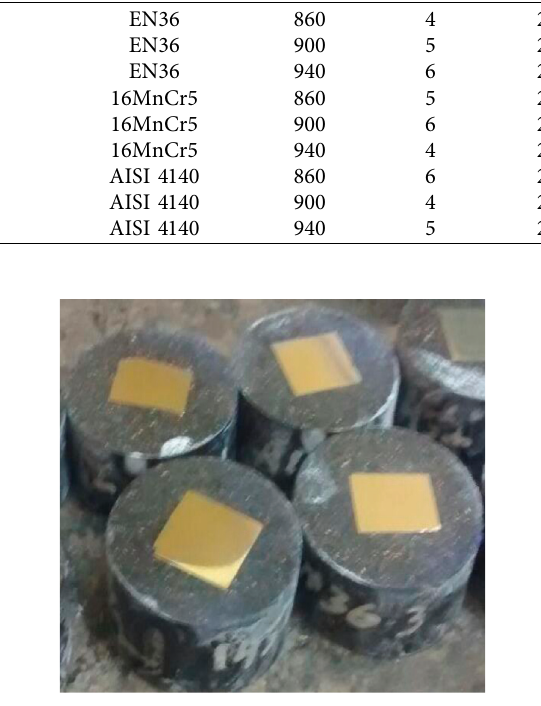
Figure 3: Specimen prepared for microscopic